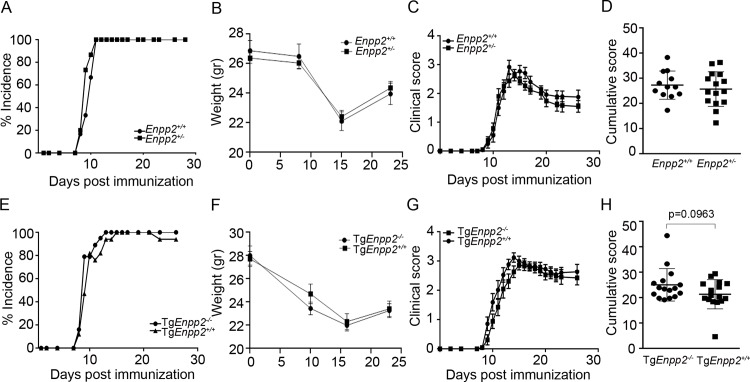
Systemic 2-fold fluctuations of ATX levels do not affect EAE pathogenesis.(A, E) EAE incidence in Enpp2+/- and TgEnpp2+/+ mice respectively, in comparison with the corresponding littermate controls. (B, F) Weights of Enpp2+/- and TgEnpp2-/- mice in comparison with their littermate controls (C, G). Clinical and (D, H) cumulative scores of EAE progression in Enpp2+/- and TgEnpp2-/- mice respectively. Values are presented as mean (± SEM). Statistical significance between experimental groups was assessed with Mann-Whitney Rank Sum Test (C and G) or Student t-test (B and F; D and H); *p<0.05.